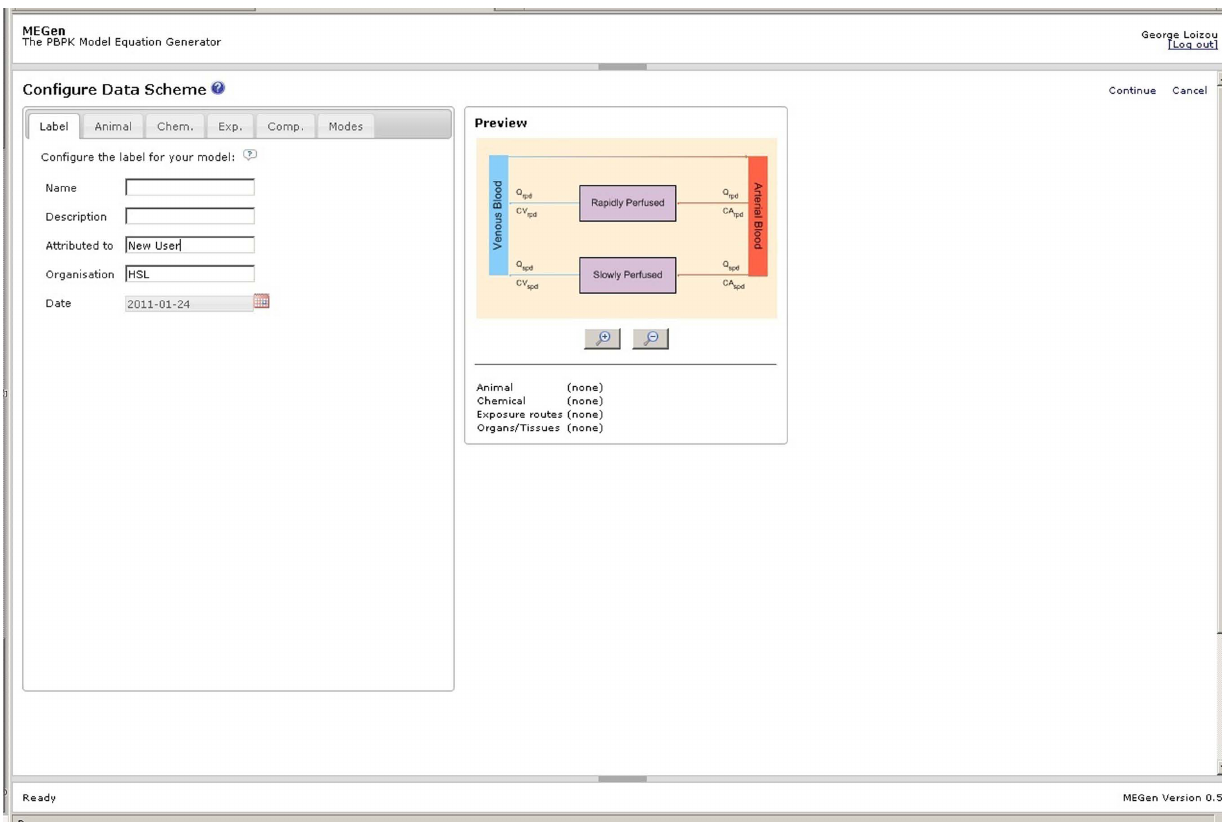
FIGURE 4 | Initial configuration page.